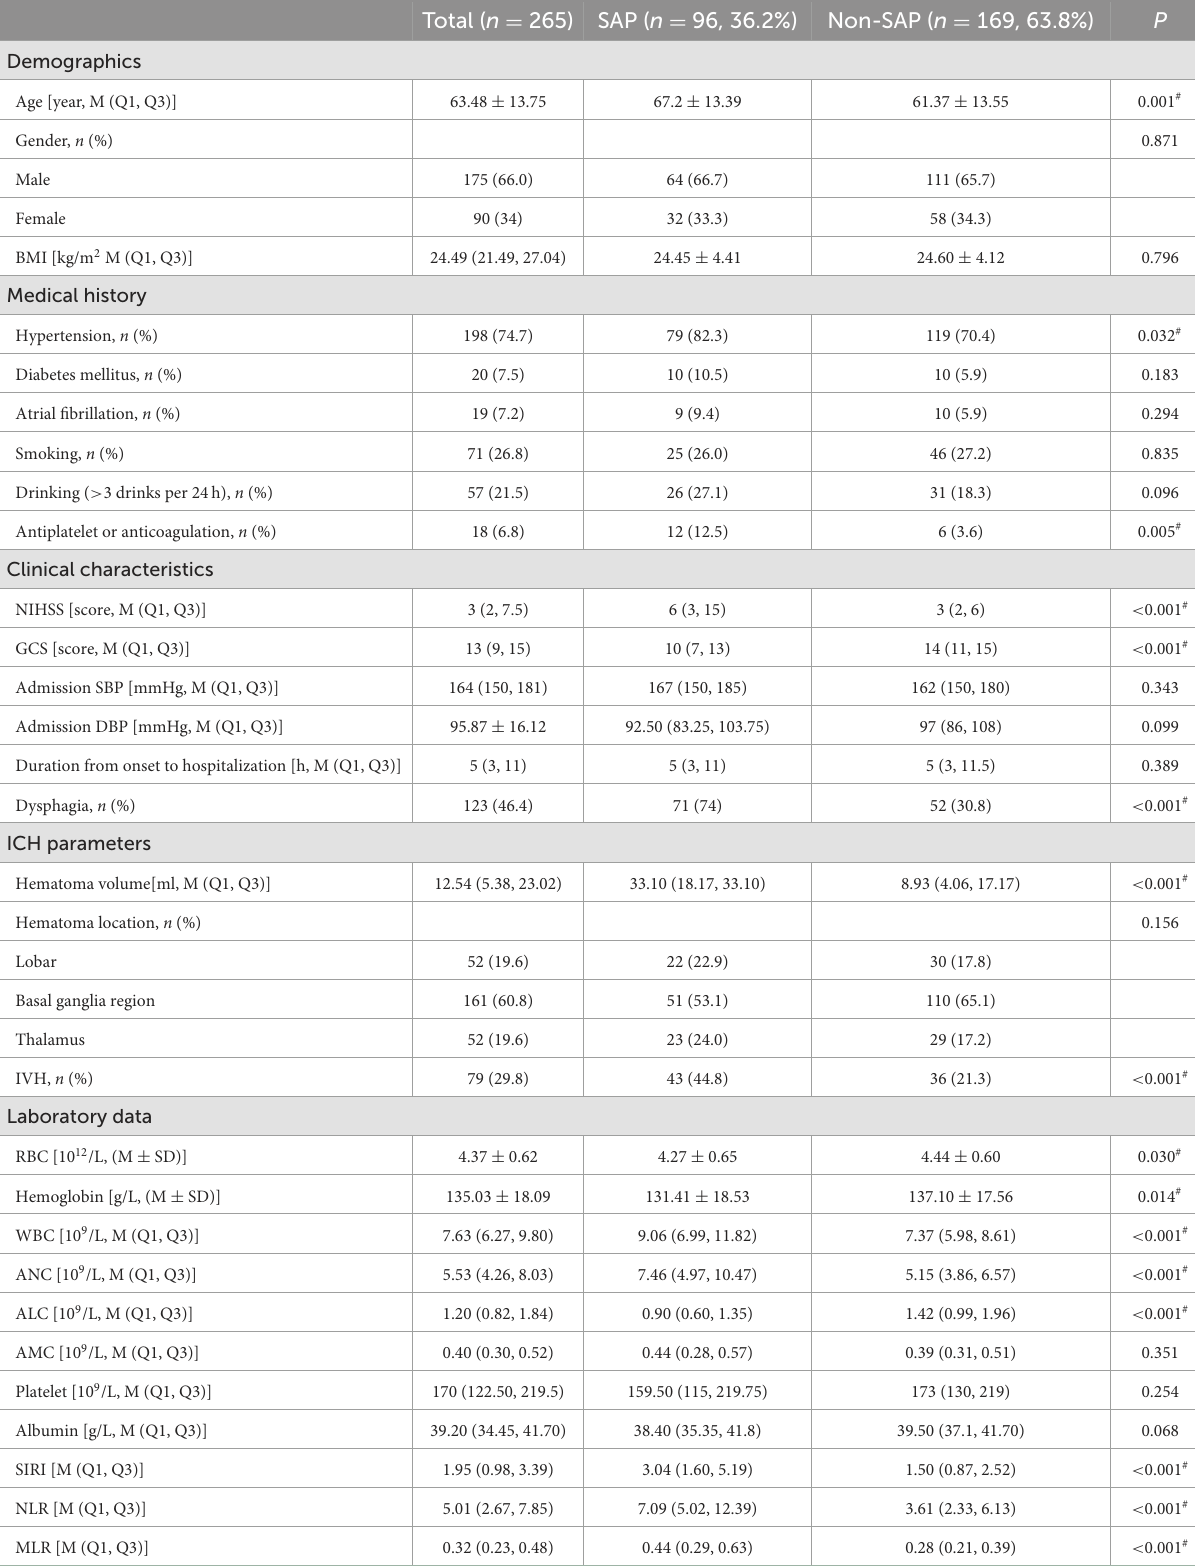
TABLE 2 General characteristics of patients with SICH according to the presence of SAP in the training cohort. Total ( n = 265) SAP ( n = 96, 36.2%) Non-SAP ( n = 169,